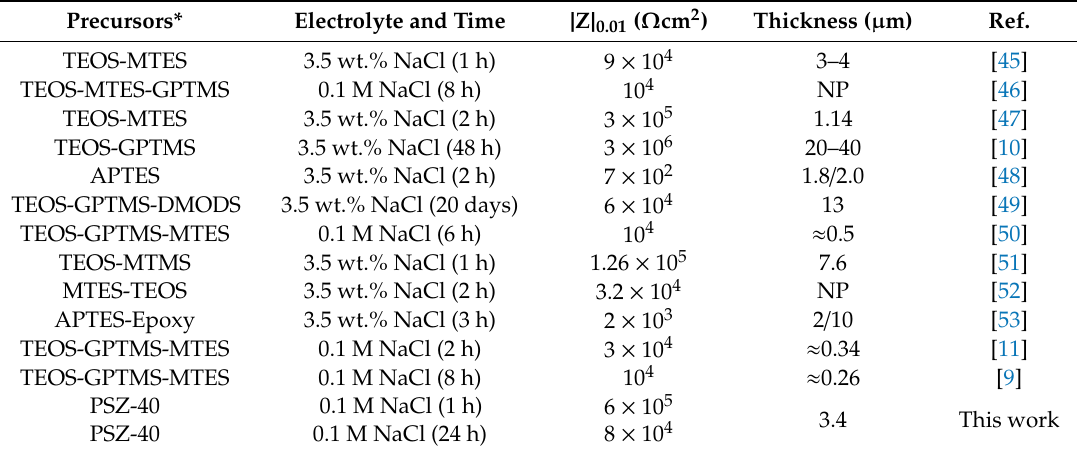
Table 3. Literature data comparison of the impedance modulus at 0.01 Hz ( | Z | 0.01 ). Only neat hybrid sol-gel coatings were considered, without the addition of any inhibitor, pigment, or dye. “NP” stands for “not provided”. [*] Abbreviations report the